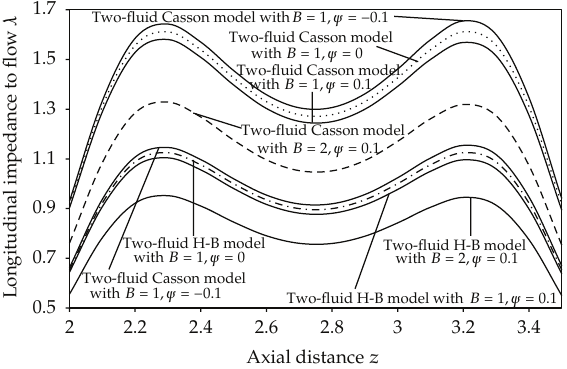
Figure 10: Variation of longitudinal impedance to flow with axial distance for two-fluid H-B and Casson models and di ff erent values of B and ψ with β (cid:7) n (cid:7) 0 . 95, θ (cid:7) δ P (cid:7) 0 . 1, φ (cid:7) α (cid:7) α H (cid:7) α C (cid:7) 0 . 2, t (cid:7) 60 ◦ , and b (cid:7) 0 .